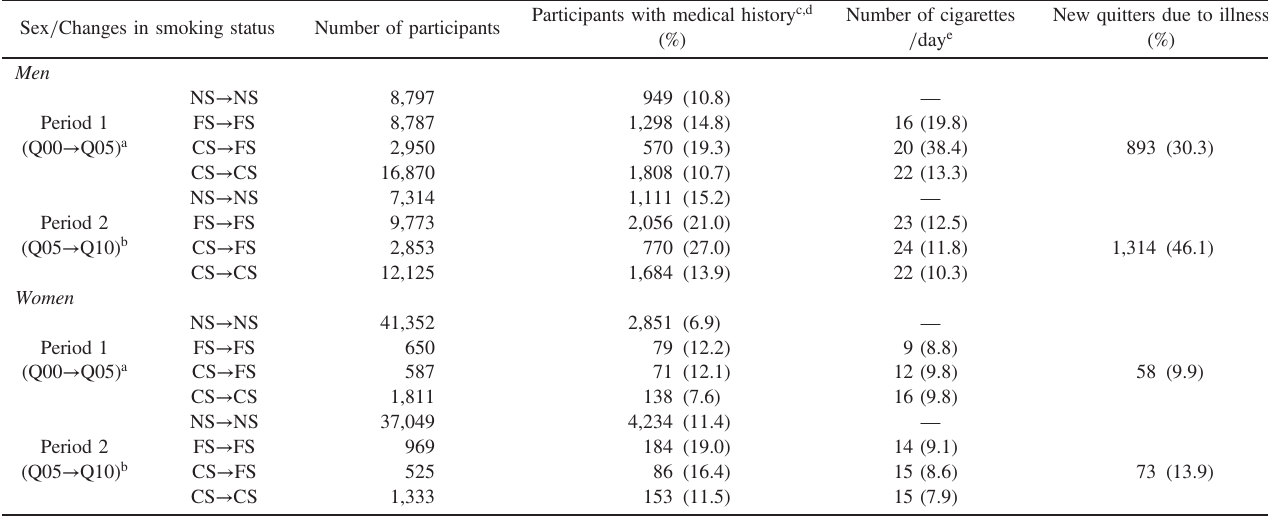
Participants with medical history